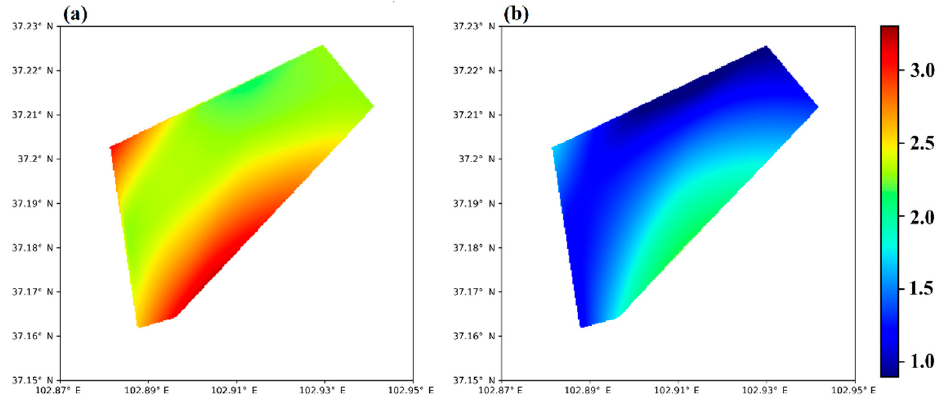
Figure 7. ( a ) The interpolation result of the experimental group in Wushaoling; ( b ) The interpolation result of the control group in Wushaoling.